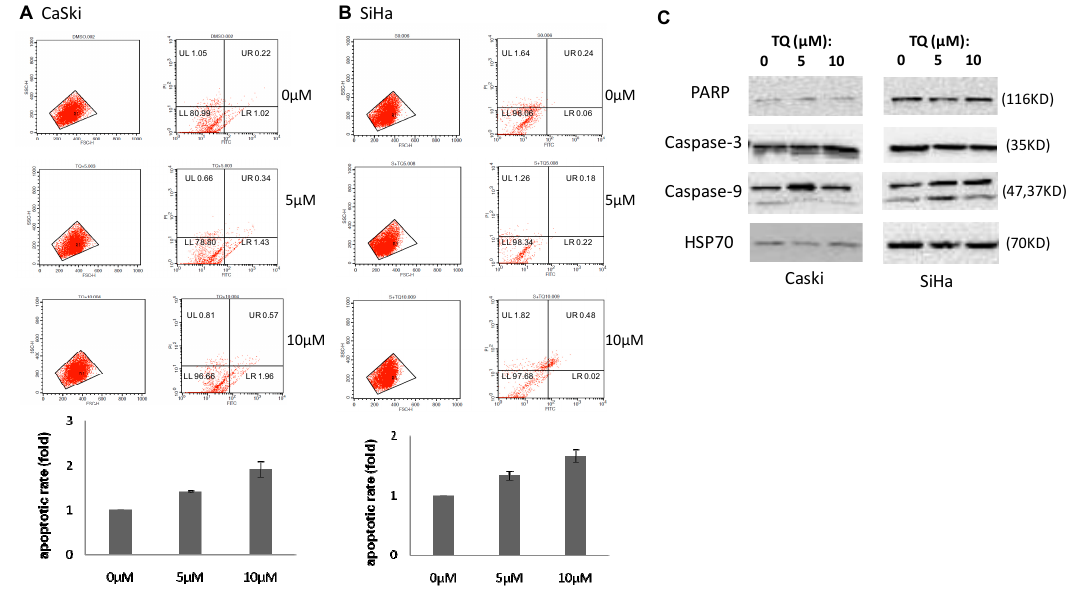
Figure 2. Effects of thymoquinone (TQ) on cellular apoptosis. Flow cytometric analysis shows that TQ increases the apoptotic rate in both CaSki ( A ) and SiHa ( B ) cells. Western blot for PARP, Caspase-3, Caspase-9 without or with different TQ treatment ( C ).